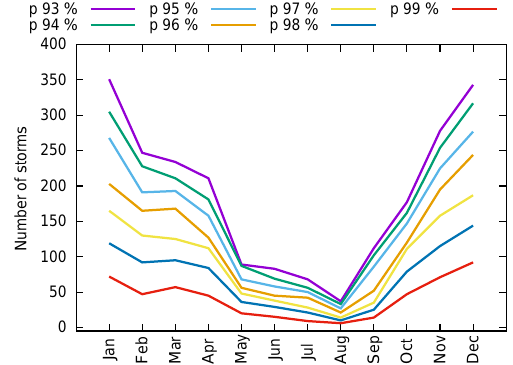
Figure 4. Number of storms vs. threshold for the northern Tyrrhe- nian reference point